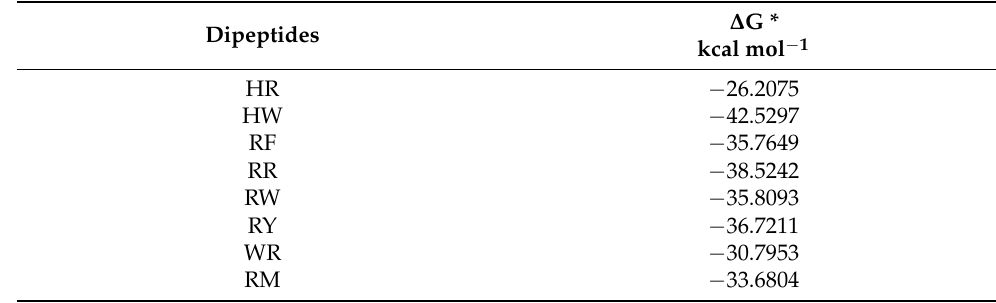
Table 1. The free energy of binding of the dipeptides from the poses shown in Supplementary Figure S2.